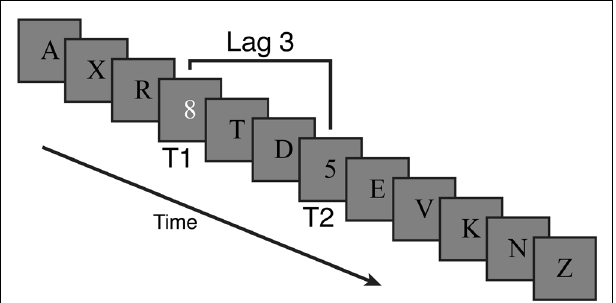
FIGURE 3 | Example trial for the attentional blink task in Experiment 2. Targets were numbers among distractor letters.The first target was white and always present.The second target was black and present on 77% of trials.